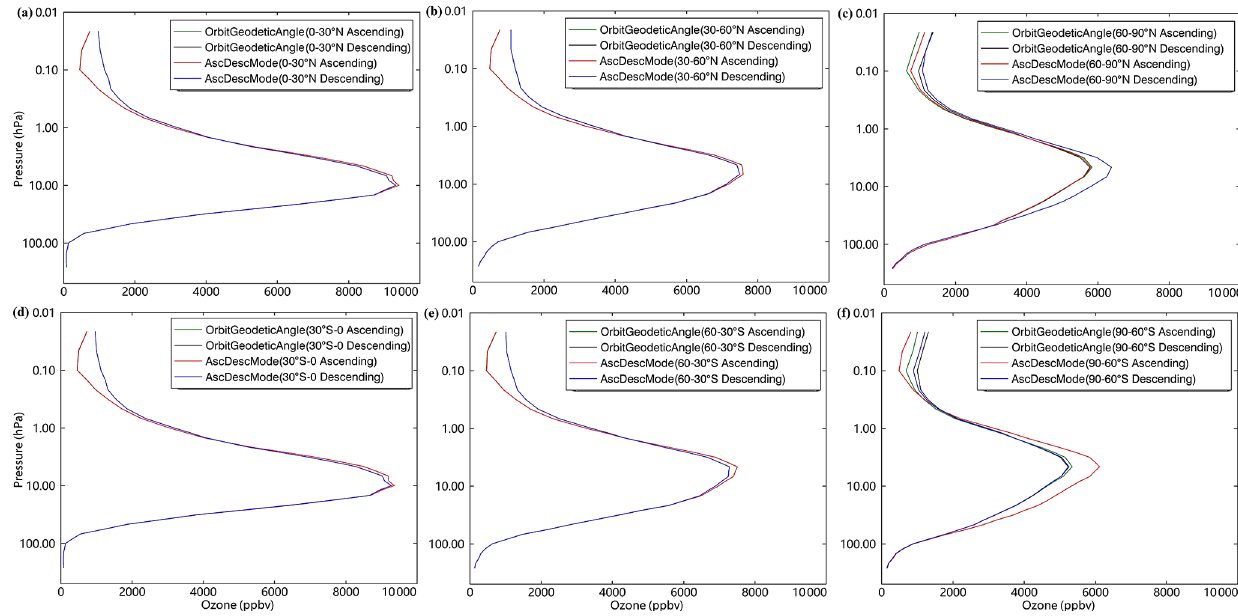
Figure 2. Ascending and descending MLS ozone profile between 261 and 0.02hPa per latitude band (30 ◦ ) for 2005–2018: (a) 0–30 ◦ N, (b) 30–60 ◦ N, (c) 60–90 ◦ N, (d) 30 ◦ S–0, (e) 60–30 ◦ S, and (f) 90–60 ◦